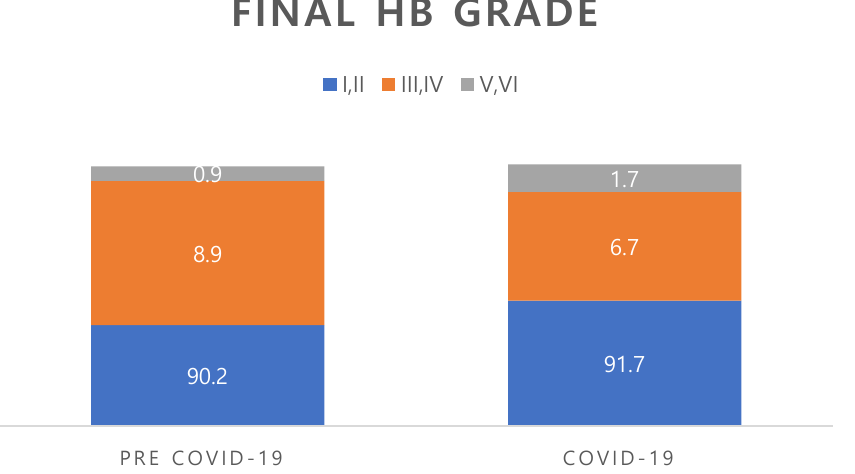
Figure 2. Comparison of the final HB grade between pre-COVID-19 and COVID-19 periods. No significant between-group difference was seen ( p = 0.525). HB; House–Brackmann.